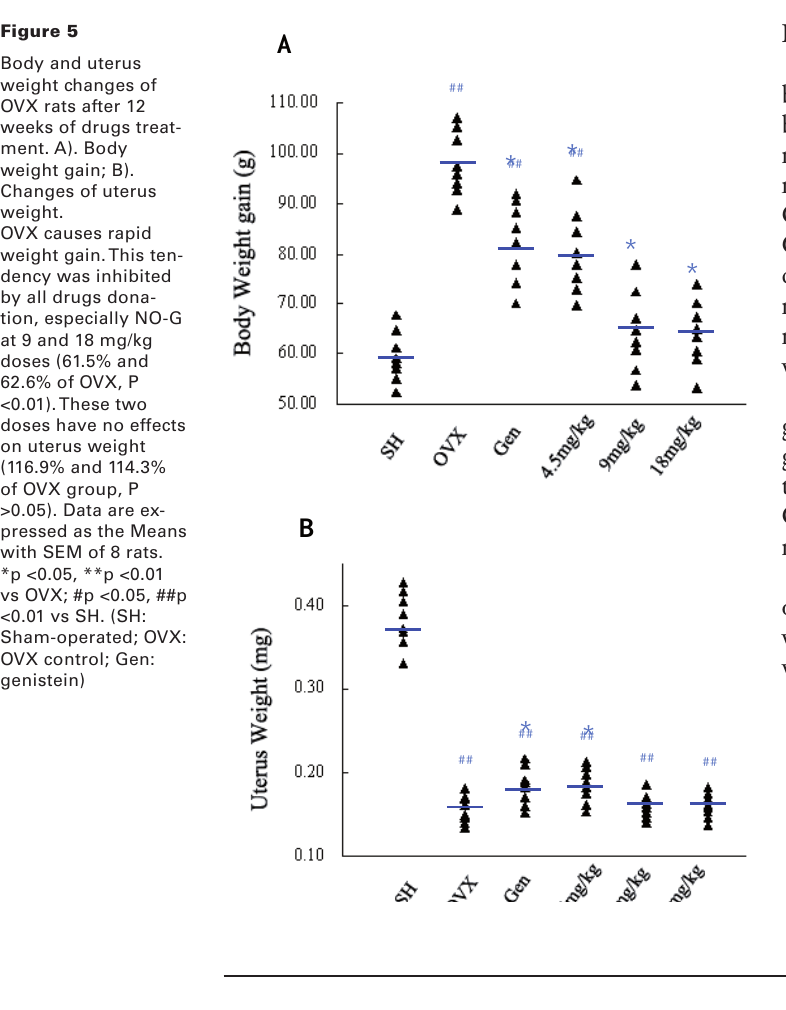
Body and uterine